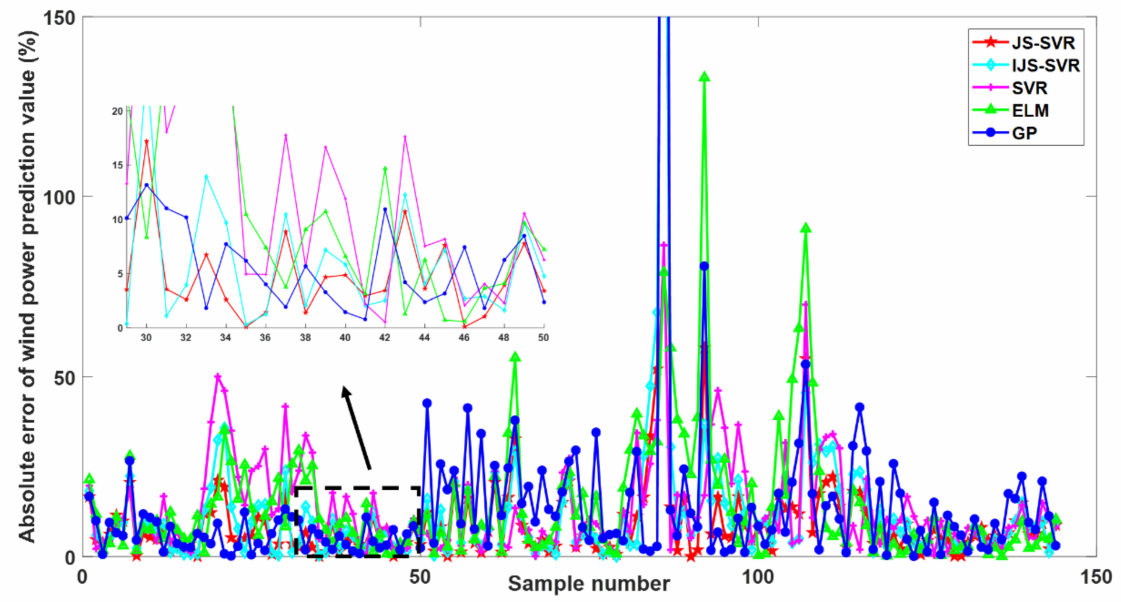
Figure 5. Curve of absolute error values of each prediction model in spring.